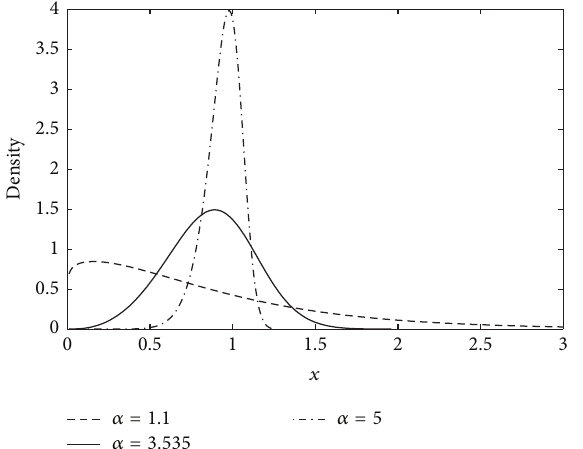
Figure 2: The TN (𝛼,𝛽) density function for some values of 𝛼 when 𝛽 = 1 .